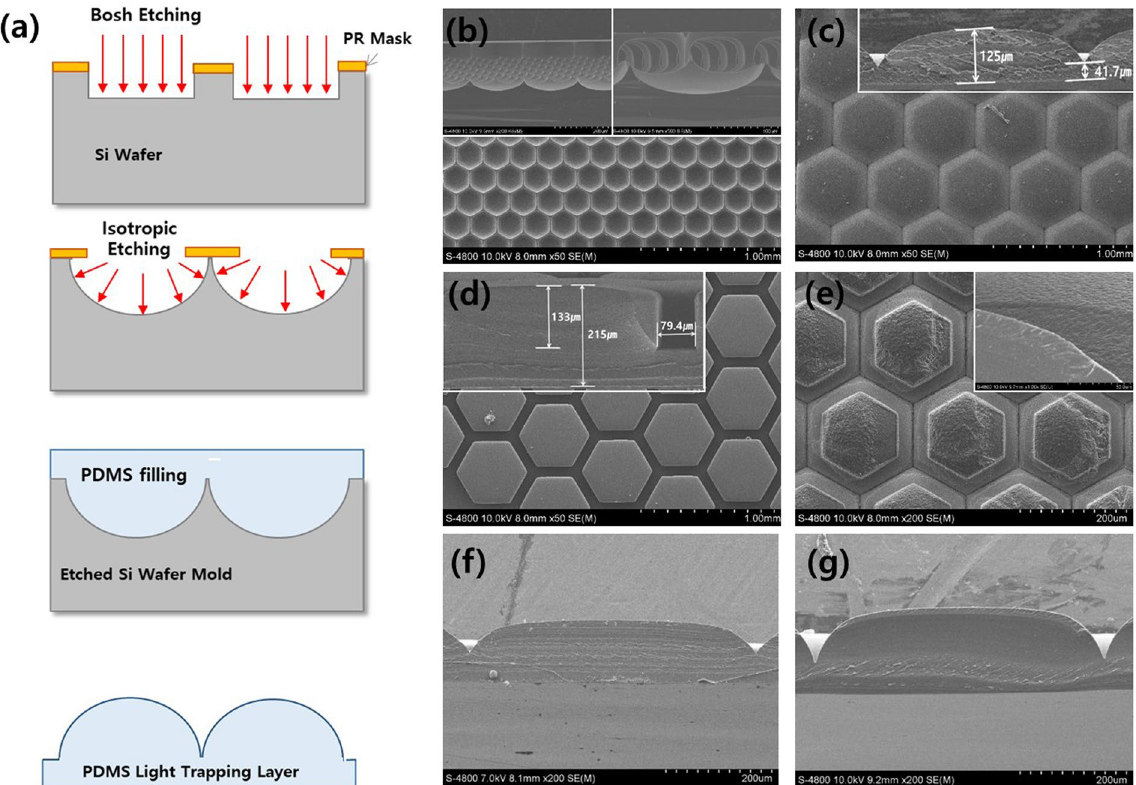
Figure 2. ( a ) Schematic diagram of the fabrication process of light-trapping layers, from etching the silicon (Si) wafer to molding the polydimethysiloxane (PDMS). Scanning electron microscopy (SEM) images of the ( b ) Si wafer master mould in plane and cross-sectional view and light-trapping layers with a ( c ) lens array, ( d ) pillar- shaped lens array, ( e ) lens array with rough surfaces (inset: cross-sections), ( f ) flat-topped lens array, and ( g ) lens array with spaces between